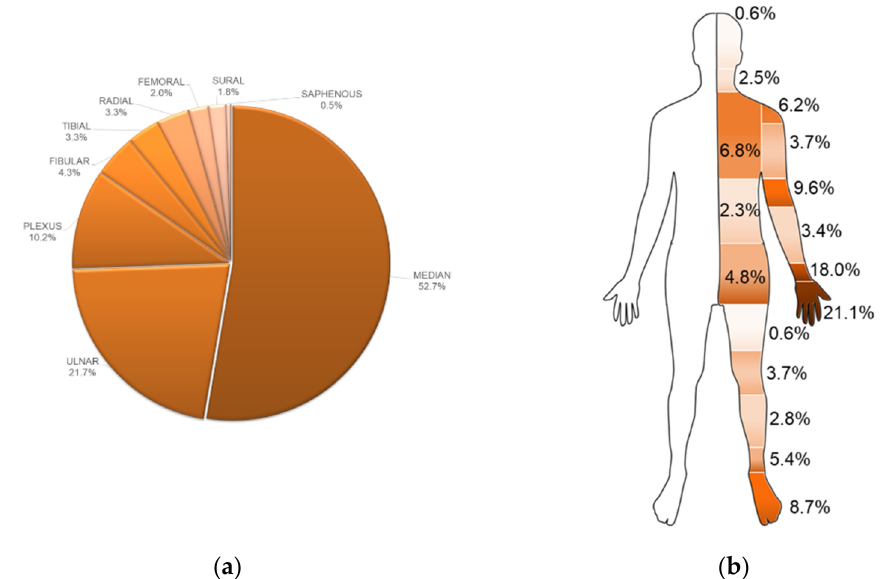
Figure 1. ( a ) Percentages of the citations of the most common nerves assessed by ultrasound (US). ( b ) Percentages of the citations of the body parts.